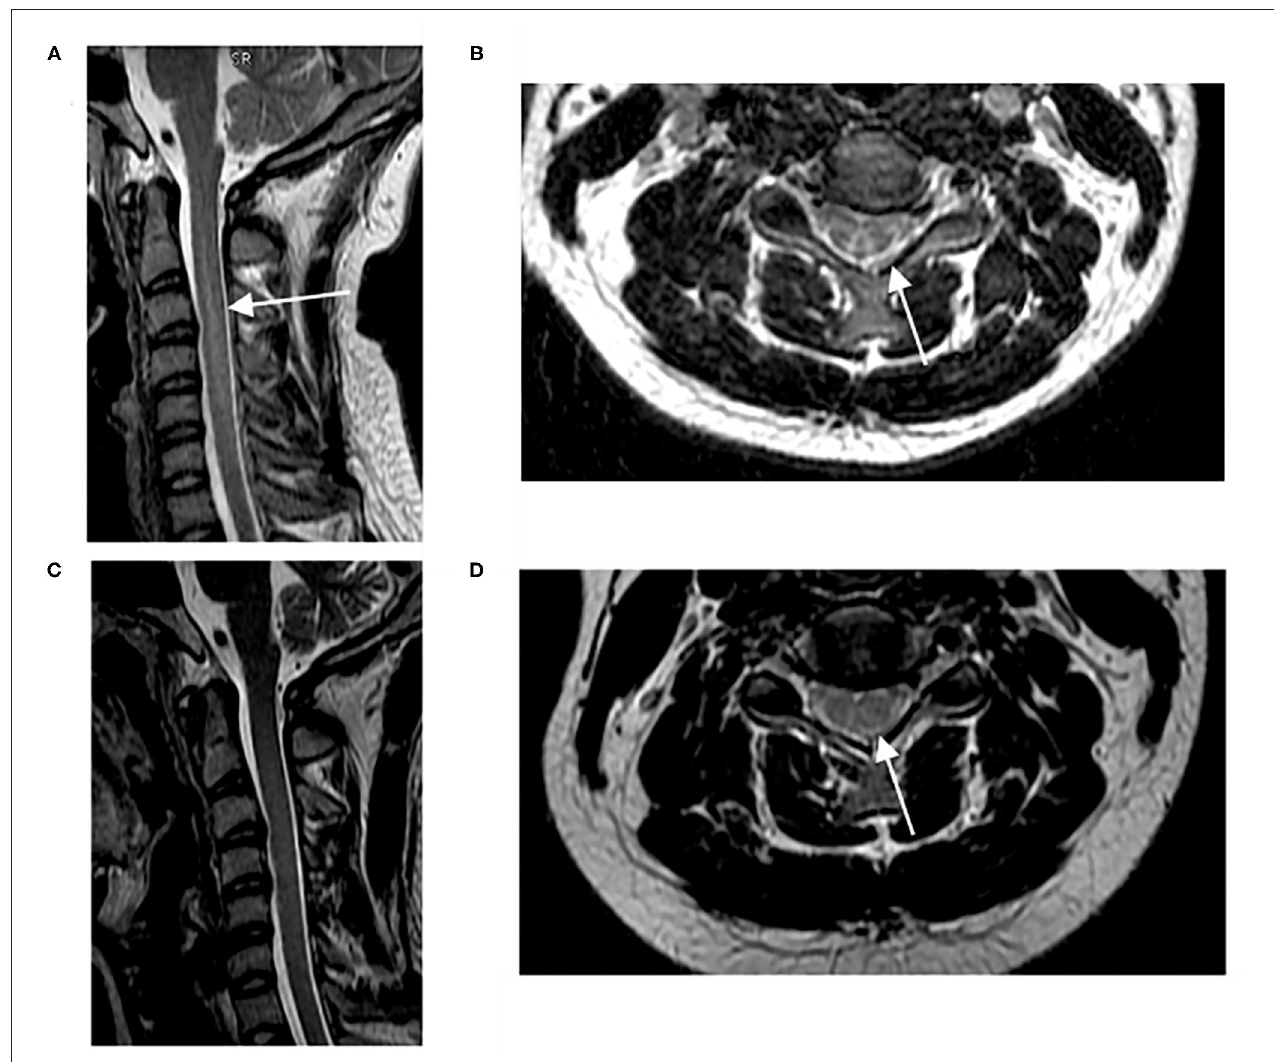
FIGURE 1 | Spinal cord MRI pre- and after-treatment. (A,B) T2 hyperintensity of posterior column from C2–C6 pre-treatment; (C) Sagittal T2-hyperintensity of posterior column from C2–C6 resolved 4 months after treatment with mecobalamine and hyperbaric oxygen; (D) Axial inverted “V” T2-hyperintensity was blurred 4 months after